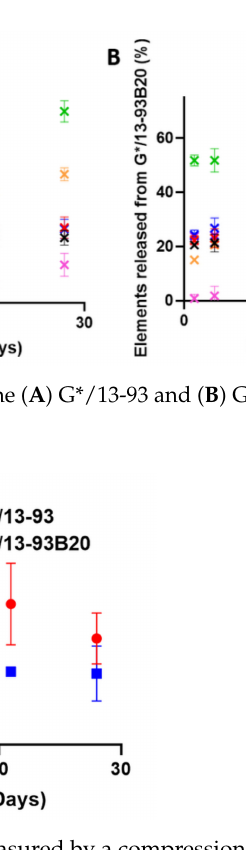
Figure 3. Elements concentrations of Si, Mg, Na, K, P, Ca, and B in the dissolution products of G*/13-93 ( • ) and G*/13-93B20 ( (cid:4) ) immersed in TRIS as a function of time. The concentrations are normalized to the sample mass.